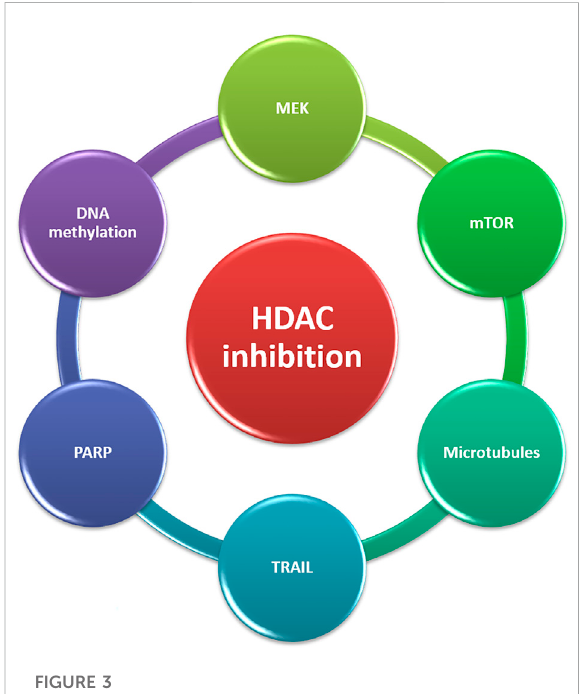
FIGURE 3 Targets for combination therapies with HDACi in